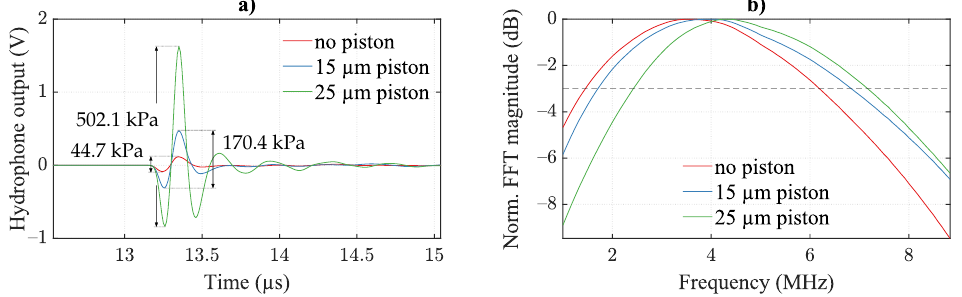
Figure 9. Acoustic measurements of CMUT response to a 100ns pulse. ( a ) Raw waveform from hydrophone voltage. ( b ) Corresponding Fourier transform of the received waveform including hydrophone calibration. Dotted line indicates − 3 dB level for bandwidth evaluation. Surface sound pressure values are noted in ( a ) including hydrophone calibration and diffraction loss. CMUTs are actuated with 90 parallel cells comprising no pistons, and 15µm and 25µm wide